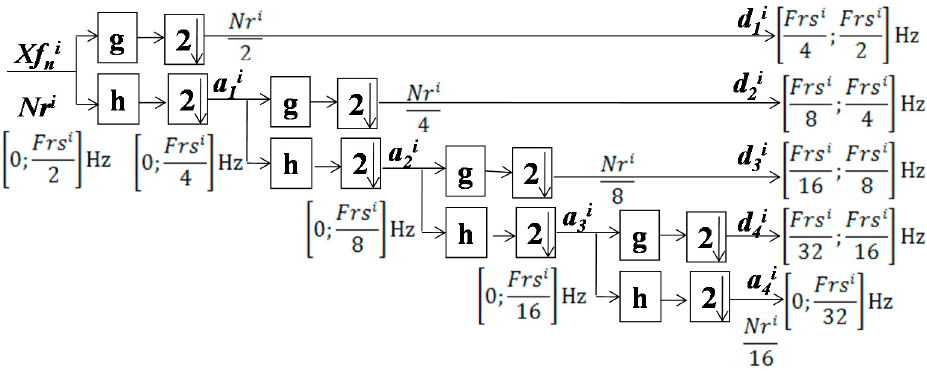
Figure 5. The adaptive-rate discrete wavelet transform (ARDWT) scheme with four levels of Figure5. decomposition.